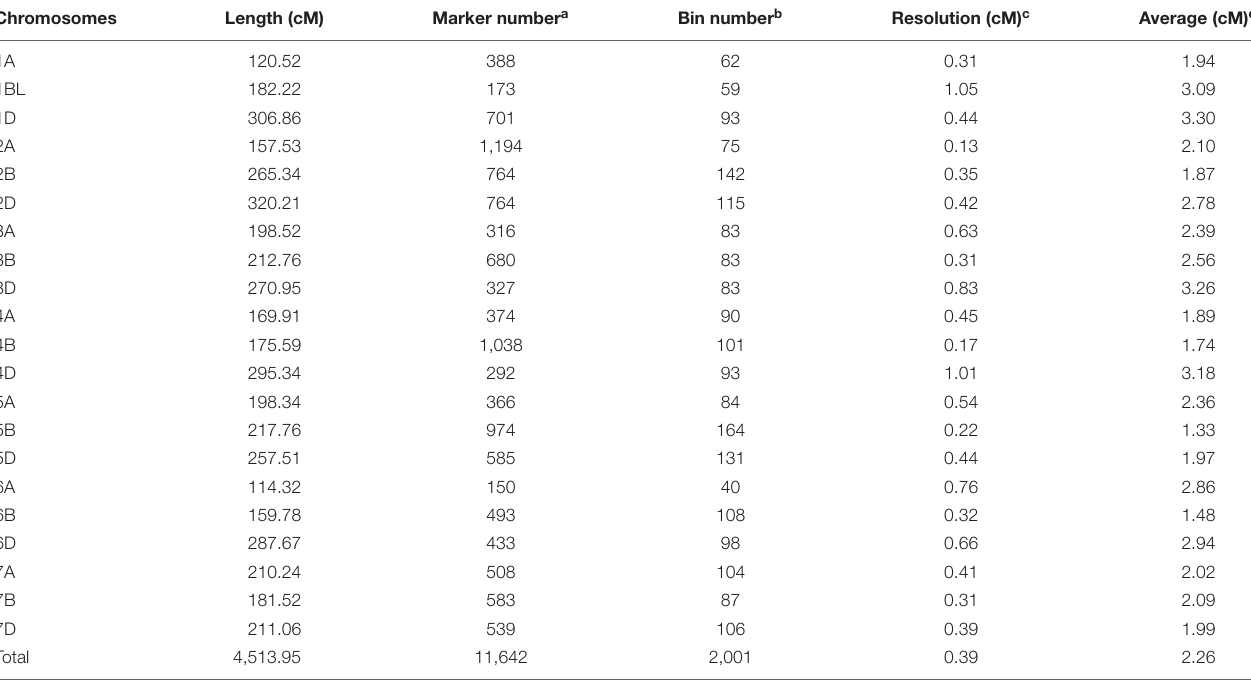
a Distribution of 11,642 markers on the 21 wheat chromosomes. SNP markers were derived from Affymetrix 55K SNP Array, and SSR markers were obtained from the United States Department of Agriculture (https://wheat.pw.usda.gov). b The 11,642 markers had 2,001 patterns of segregation; hence, 2,001 markers were chosen to represent each bin in genetic map, and bins were defined as loci on each chromosome and consisted of at least 1 marker. c Resolution means the average distance between two linked markers. d Average means the average distance between two neighbor loci (bins) according to the genetic map.